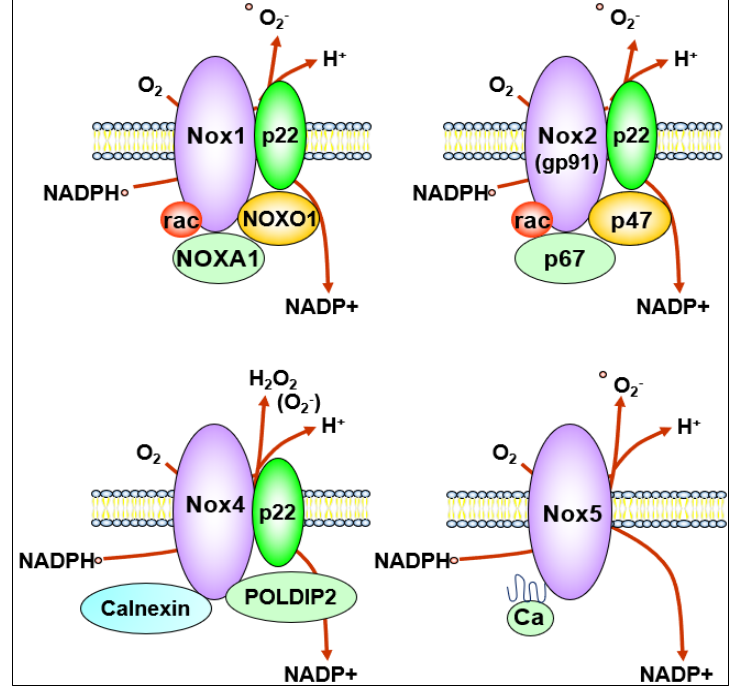
Figure 3. NOX isoforms expressed in endothelial cells.